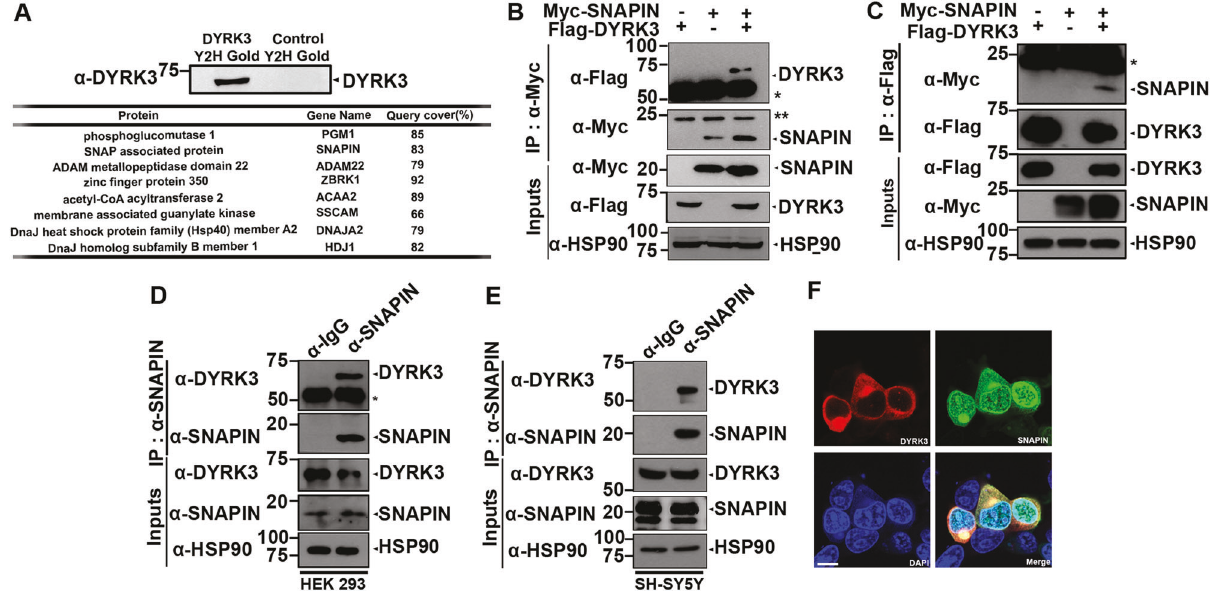
Fig. 1 DYRK3 interacts with SNAPIN in mammalian cells. A Yeast two hybrid assays were performed using Matchmaker Gold System and the Y2HGold yeast strain co-transformed with pGBKT7-DYRK3 plasmid and pGBKT7-prery vector. The expression of the bait vector was con fi rmed by immunoblotting with anti-DYRK3 antibody. After screening the human brain library, positive clones were selected by growth on the media de fi cient of selective amino acids. The binding-candidate cDNAs from prey vectors were veri fi ed by PCR ampli fi cation using the T7 sequencing primer. The table below denotes the protein names and gene symbols of screened products. B HEK293 cells were transfected for 24 h with a plasmid encoding Myc-SNAPIN or Flag-DYRK3 alone or in combination. Cell lysates were immunoprecipitated with anti-Myc antibody, followed by immunoblotting with the indicated antibody. Hsp90 served as a loading control. The asterisk indicates IgG heavy and light chain. C HEK293 cells were transfected for 24 h with a plasmid encoding Myc-SNAPIN or Flag-DYRK3 alone or in combination. Cell lysates were immunoprecipitated with anti-Flag antibody, followed by immunoblotting with the indicated antibody. The asterisk indicates IgG light chain. D , E HEK293 D and SH-SY5Y cell lysates E were immunoprecipitated with either anti-SNAPIN antibody or pre-immune IgG as a control, followed by immunoblotting with the indicated antibody. The asterisk indicates IgG heavy chain. F Representative confocal images of immunostaining of HEK293 cells expressing both Flag-DYRK3 (red) and GFP-SNAPIN (green). Nuclei were counterstained with DAPI (blue). Scale bar = 10 μ